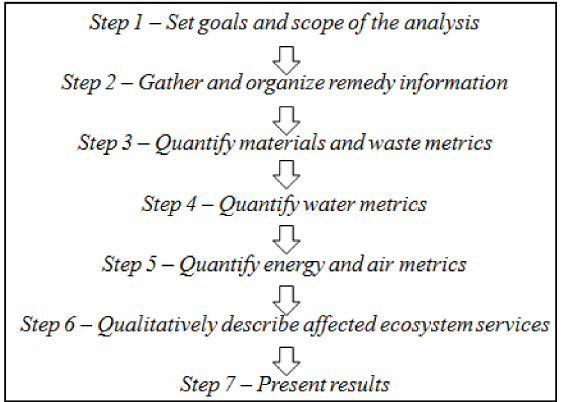
Figure 4. Steps in footprint methodology (modified from